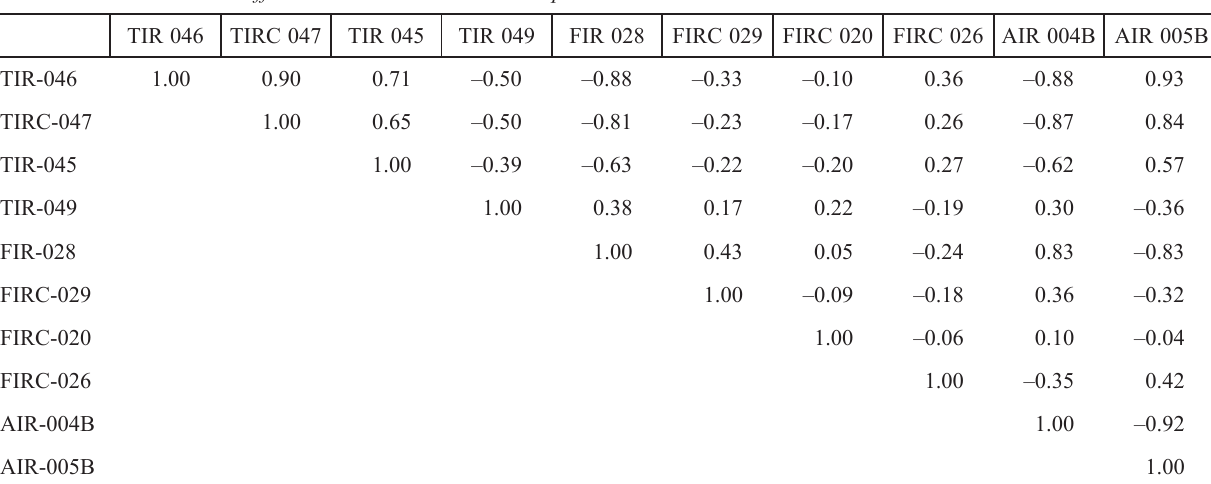
Table 4 – Correlation coefficient results within 2015 data period